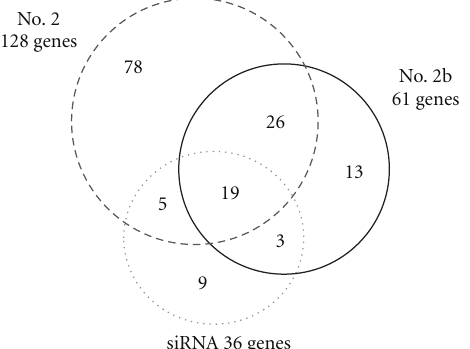
Figure 3: O ff -target e ff ects induced by synthetic shRNAs. HeLa cells were transfected with the indicated RNAs. After 48 h, the expression of about 20,000 protein-coding genes was analyzed by microarray analysis. The overlap of genes that showed a more than 2-fold decrease in expression as compared with the control siRNA- transfected sample is shown. The number in the overlapping region of the Venn diagram represents shared genes. Note that the LMNA gene is included in the commonly downregulated genes.